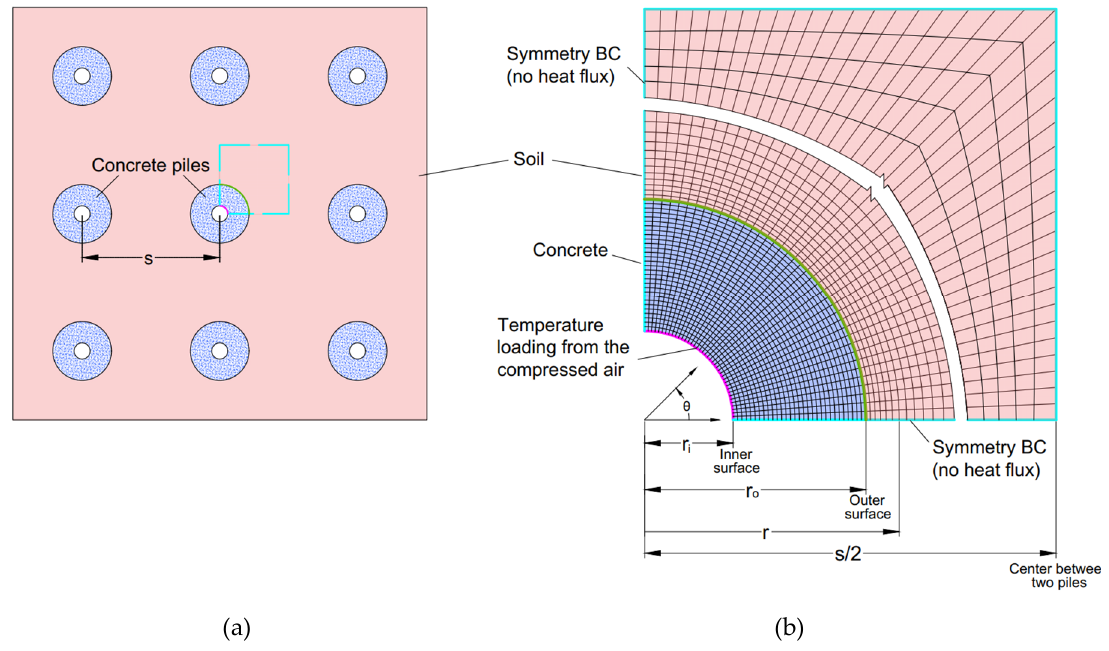
Figure 5. Analytical model of ( a ) group piles and ( b ) 2D plane strain model.